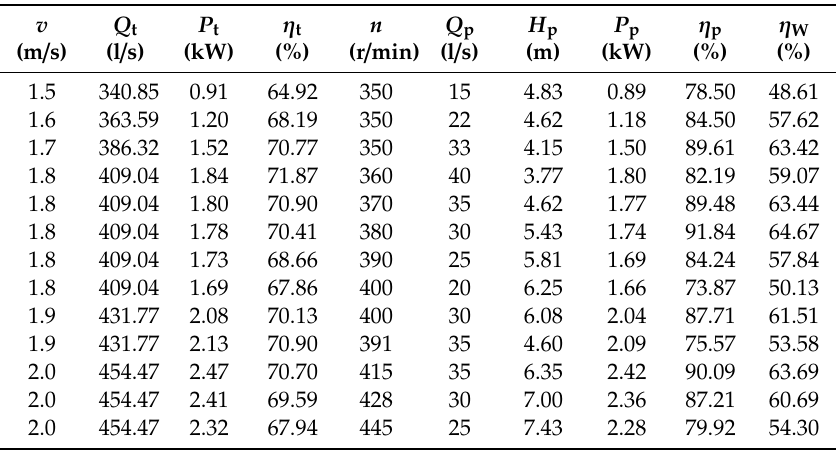
Table 4. The external characteristics of the